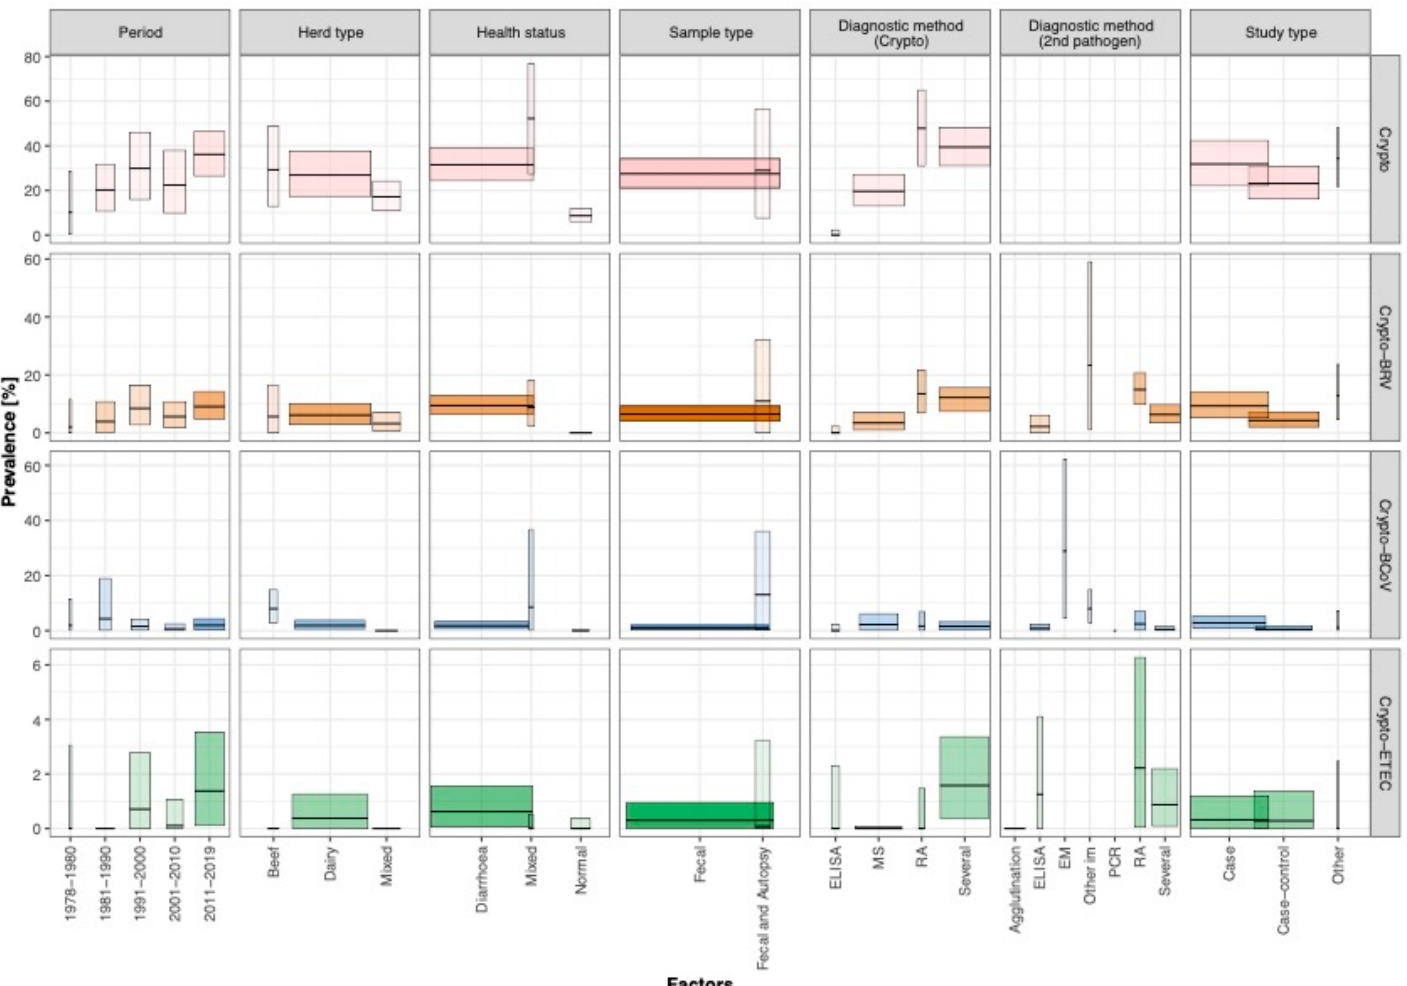
Figure 2. Crypto prevalence and associated concurrent infections presented as box plot and stratified by influencing factors (i.e., period, herd type, health status, sample type, diagnostic method, and study type). One colour is assigned to a specific Crypto infection. The darker the colour within a colour range, the more animals were included in the respective factor. The wider the box plots are, the more (sub)-studies were considered in the respective factor. N.B. A detailed description of all analysed factors can be found in Tables S1–S4.